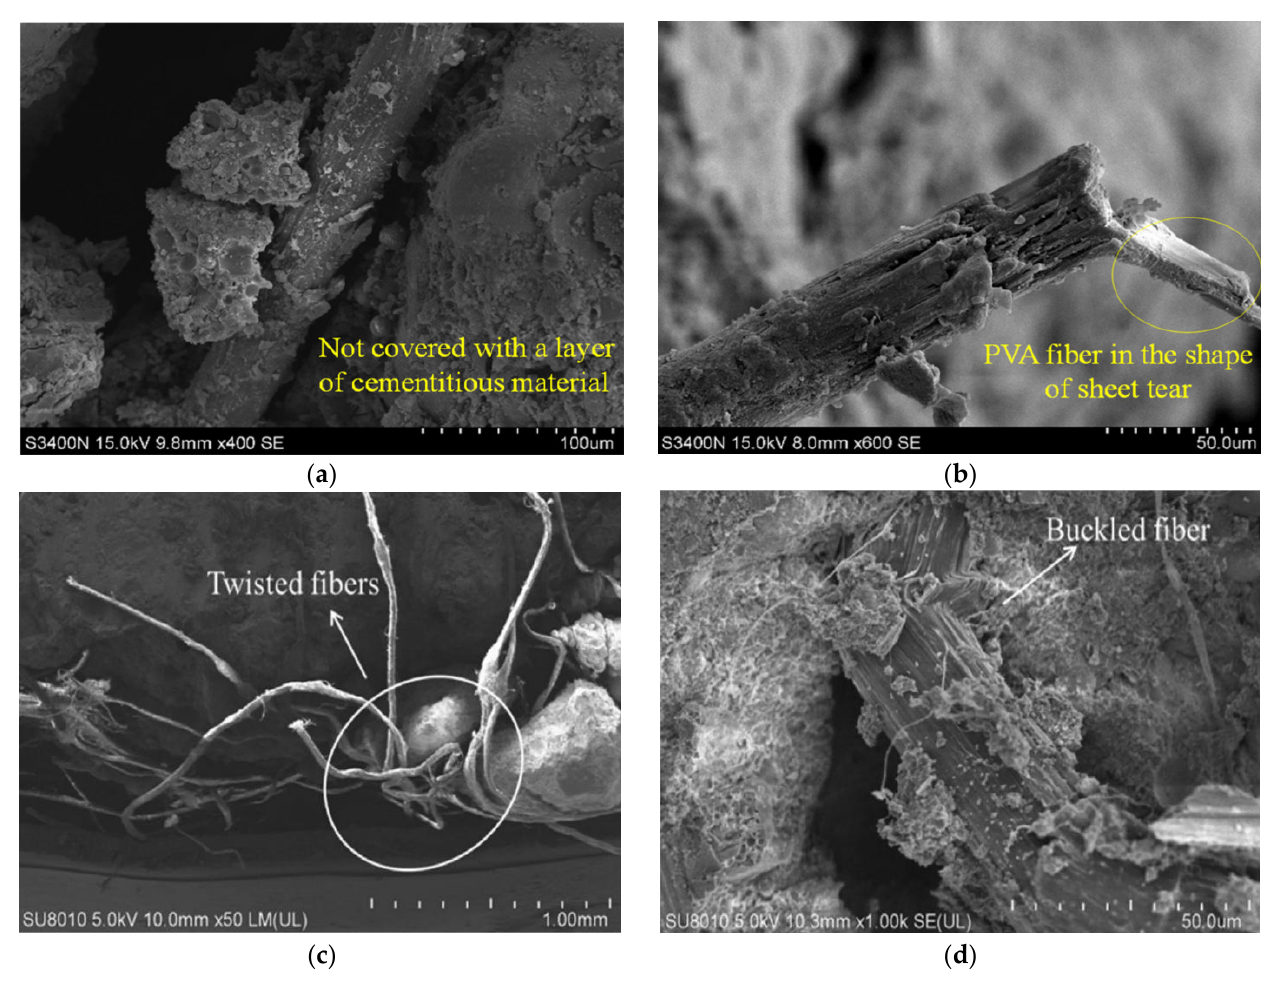
Figure 1. ( a ) Overlapping of fiber and matrix and ( b ) fiber pulling out from matrix. Adapted from Xiao et al. [53]; licensed under CC BY 4.0 (open access). SEM images of the ( c ) twisted fibers and ( d ) buckled fiber.Adapted with permission from [44], copyright 2021 Elsevier.